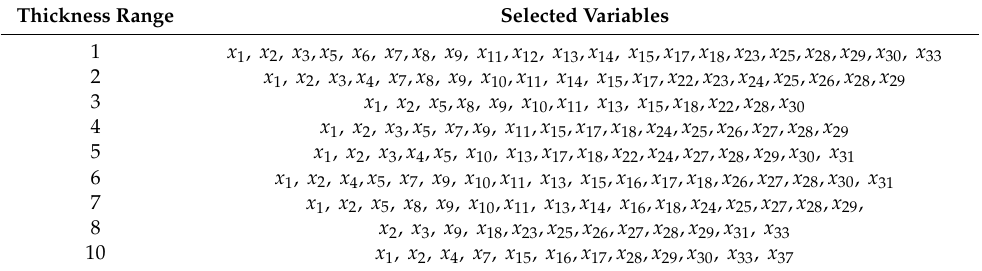
Table 3. Selected input variables for the models related to steel grade A for the thickness ranges with a su ffi cient number of data.